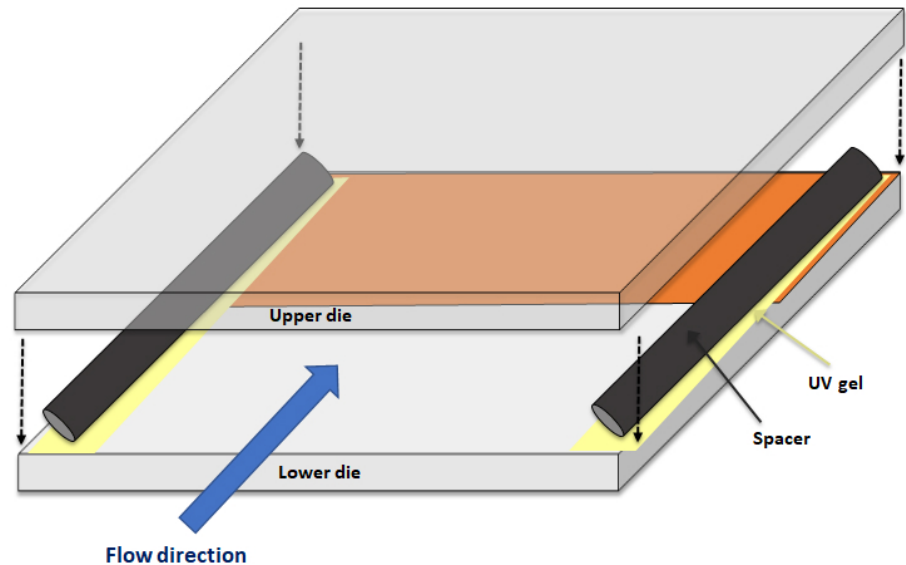
Figure 18. Test vehicle